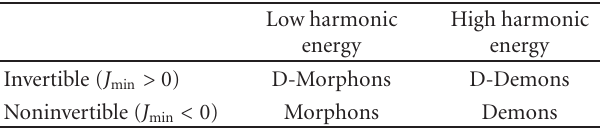
Table 4: Classification of the registration algorithms for variable contrast